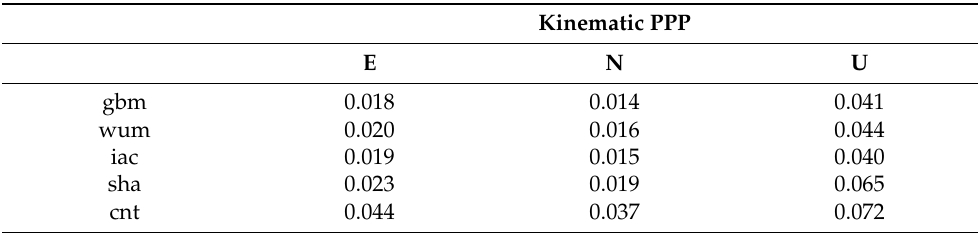
Table 8. The median of the positioning accuracy (unit: m) in the ENU directions calculated from BDS-3 Kinematic PPP with different precise products.